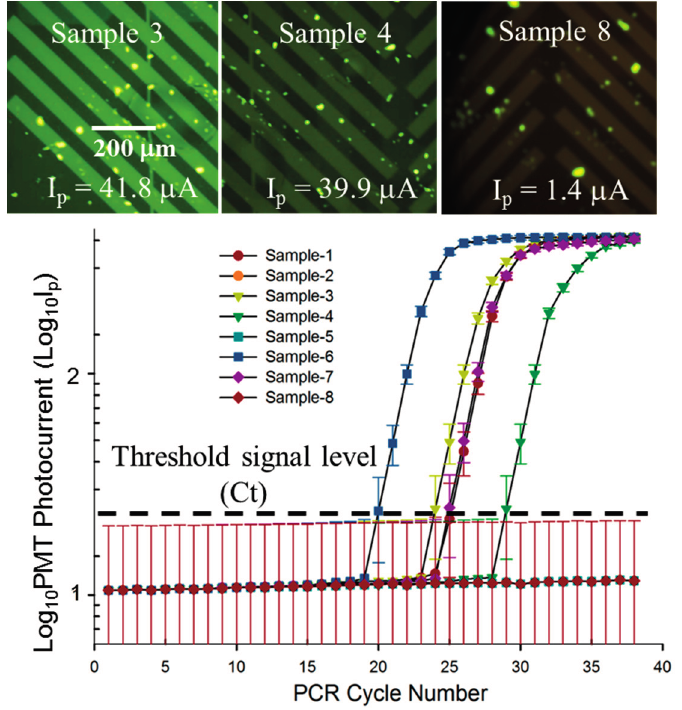
Figure 6. Plot showing qRT-PCR curves obtained during the multiplexed assay using blind panel samples of Table 1b. The fluorescent photomicrographs show a 10× magnified image, centered within the PCR droplets following 38 amplification cycles ( I p in μ